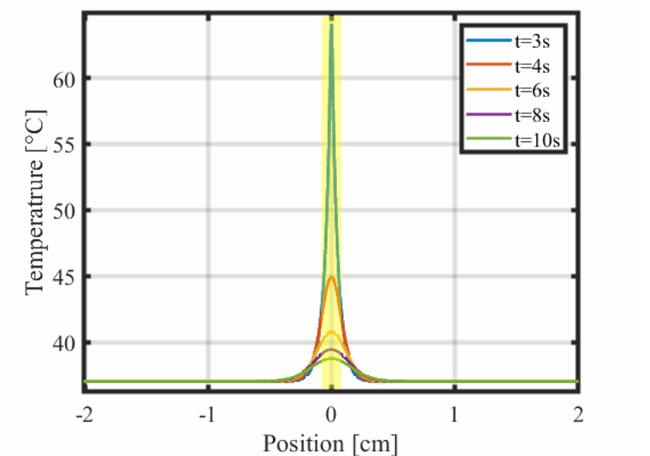
Figure 6. Heat distribution along the main focus axis during a sonication with t on = 3 s and t of f = 10 s at time t = 3 s, 4 s, 6 s, 8 s, 10